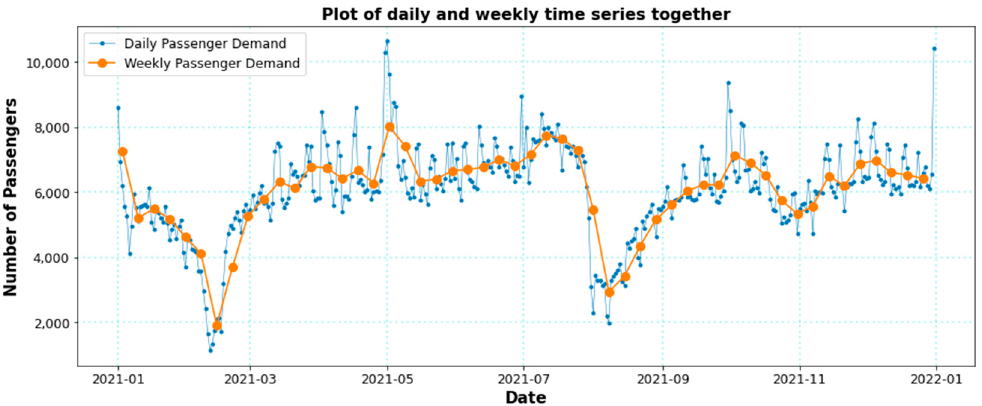
Forecasting 2022 , 4, FOR PEER REVIEW Figure 2. Combined plots of daily and weekly time series data. Figure 2. Combined plots of daily and weekly time series data.